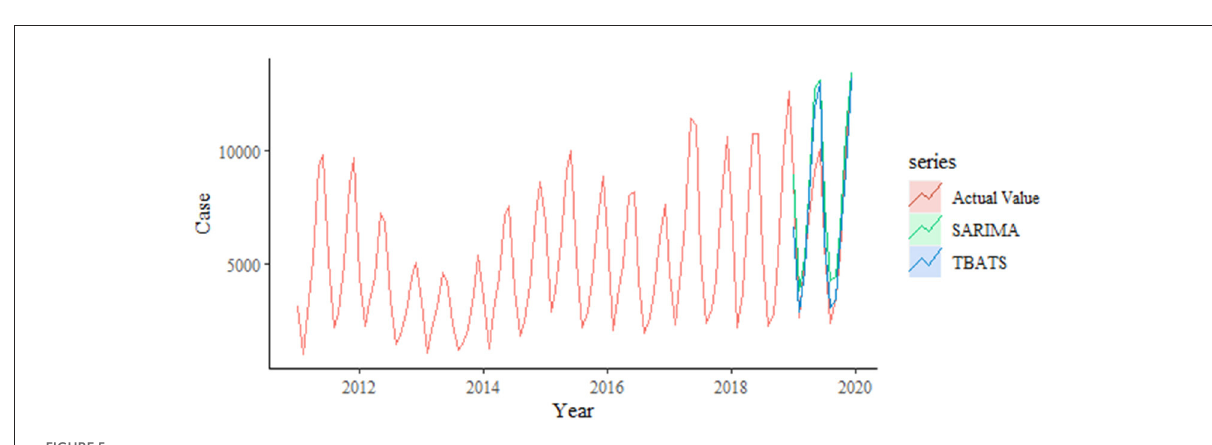
FIGURE5 Comparison of SARIMA and TBATS models prediction fit.